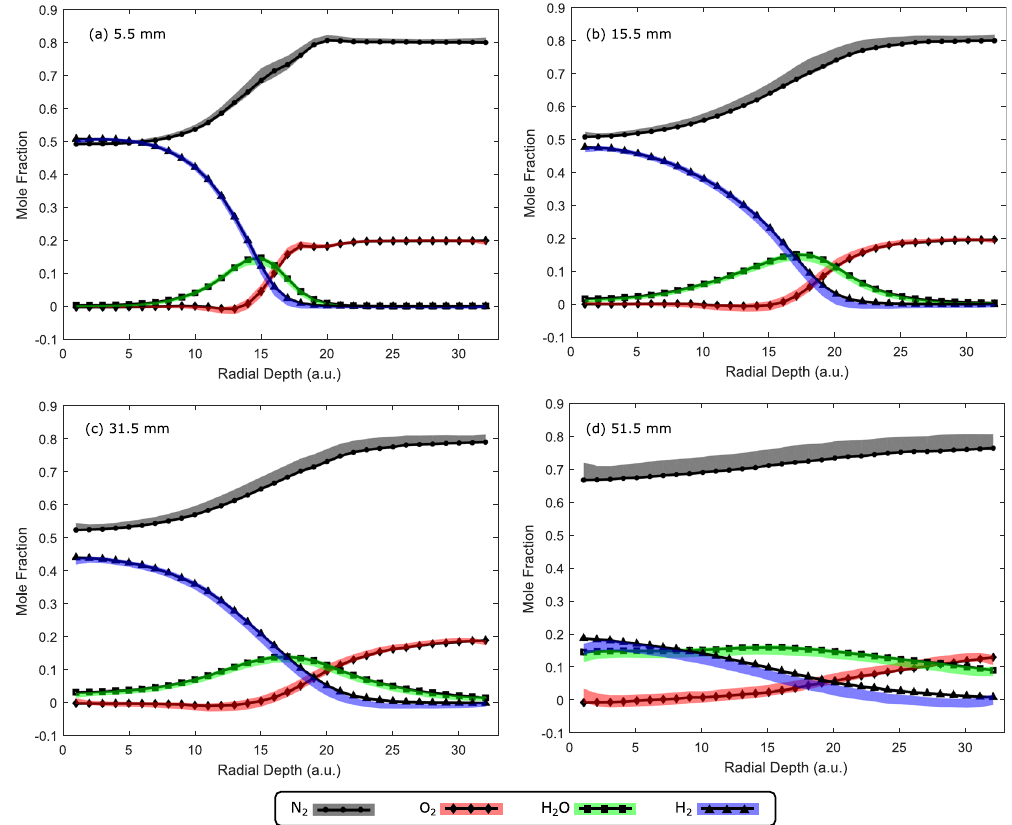
Figure 4. Mole fractions for four species measured at ( a ) 5.5 mm, ( b ) 15.5 mm, ( c ) 31.5 mm and ( d ) 51.5 mm above the nozzle. Black circles (N 2 ), triangles (H 2 ), squares (H 2 O) and diamonds (O 2 ) represent values calculated from an averaged Raman image from the cooled CCD. The gray, blue, green and red bands represent the simulated reconstruction with 25% sampling and a 1- σ error band. Radial depth is measured from the center of the